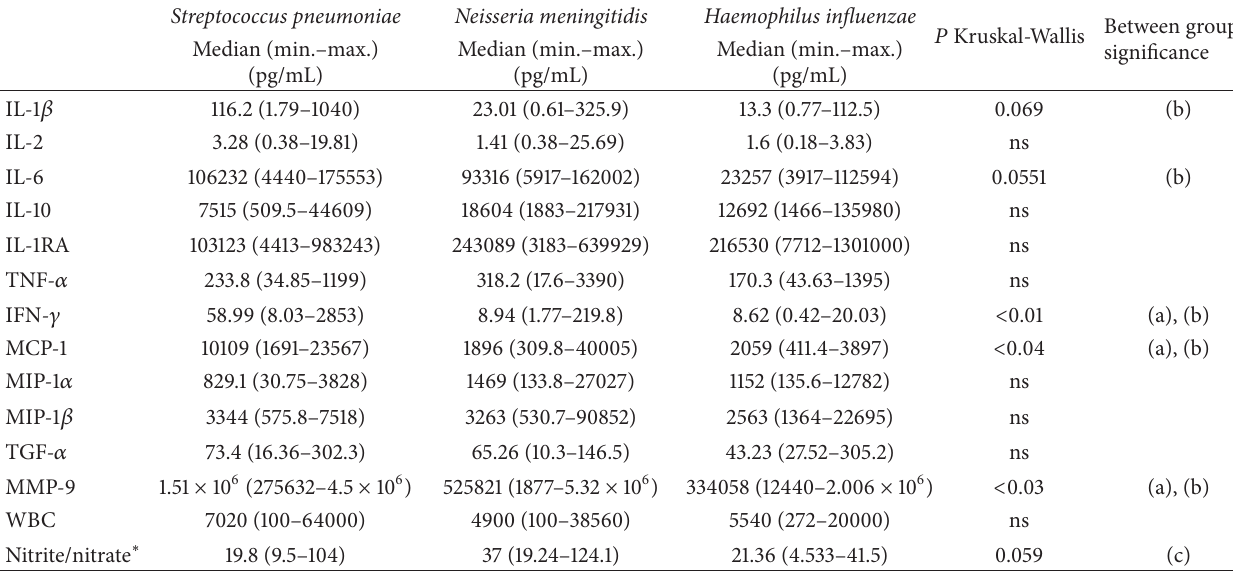
Table 2: CSF inflammatory parameters of patients infected with SP ( 𝑛 = 14 ), NM ( 𝑛 = 22 ), and Hib ( 𝑛 = 9 ).